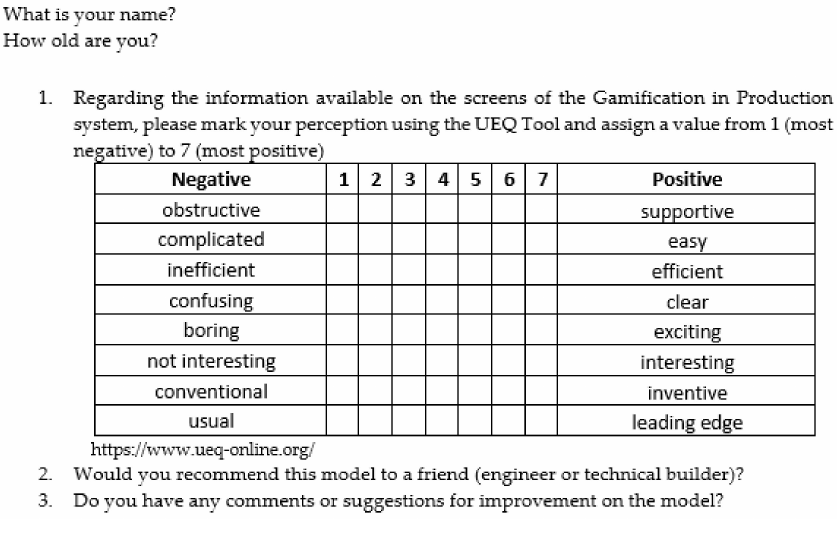
Figure A2. Engineer questionnaire. https://www.ueq-online.org/ (accessed on 13 January